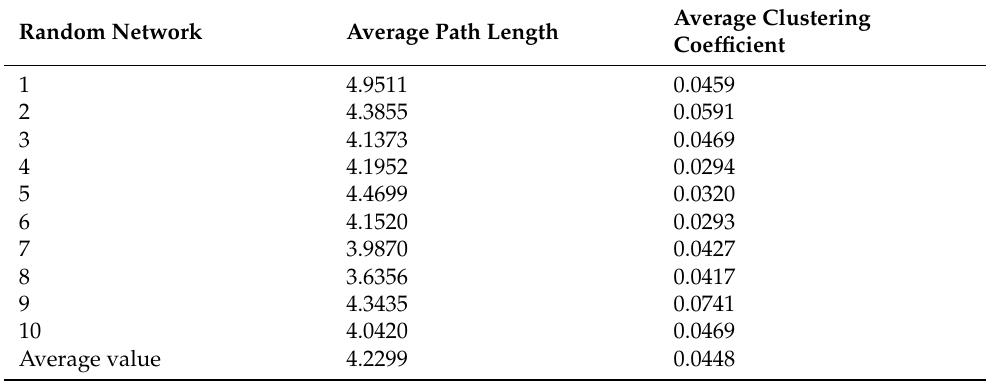
Table 8. Average path length and average clustering coefficient of randomly simulated networks.